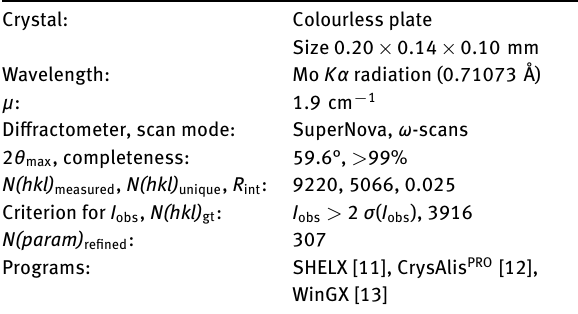
Table 2: Fractional atomic coordinates and isotropic or